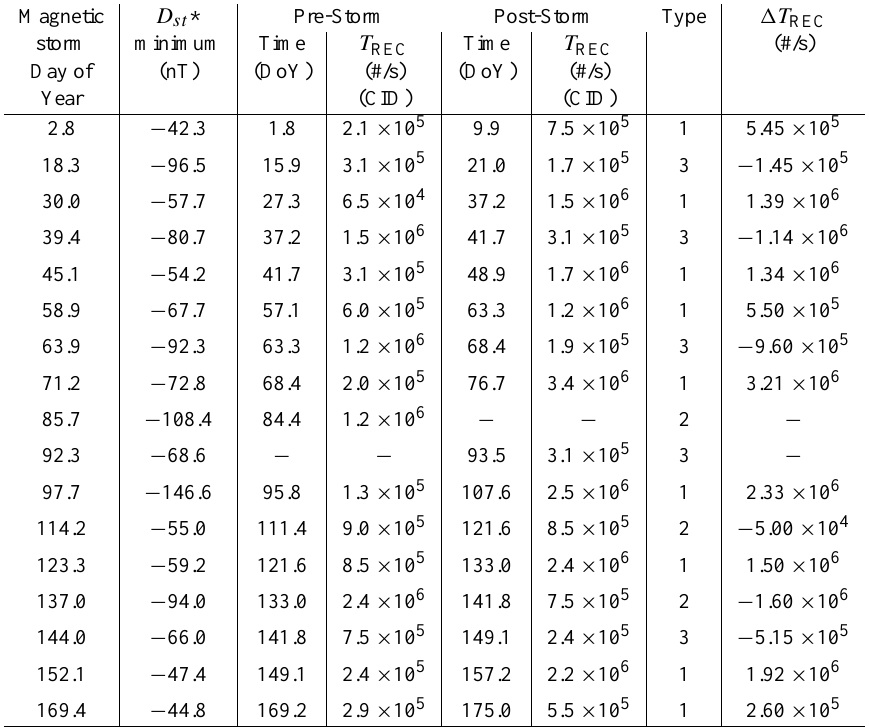
Table 1. The day of year and value of the D st * minimum for each event, together with the pre- and post-storm T REC for the CID measured at the beginning and end of each storm interval and the associated event type and change in T REC Magnetic D st